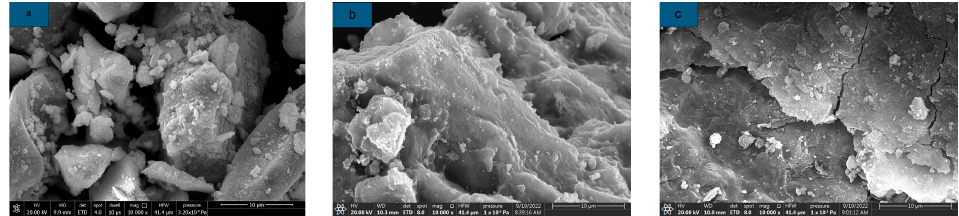
Figure 11. Microstructure of AAS with di ff erent citric acid dosages ( a ) M0; ( b ) CA2; ( c ) CA6.